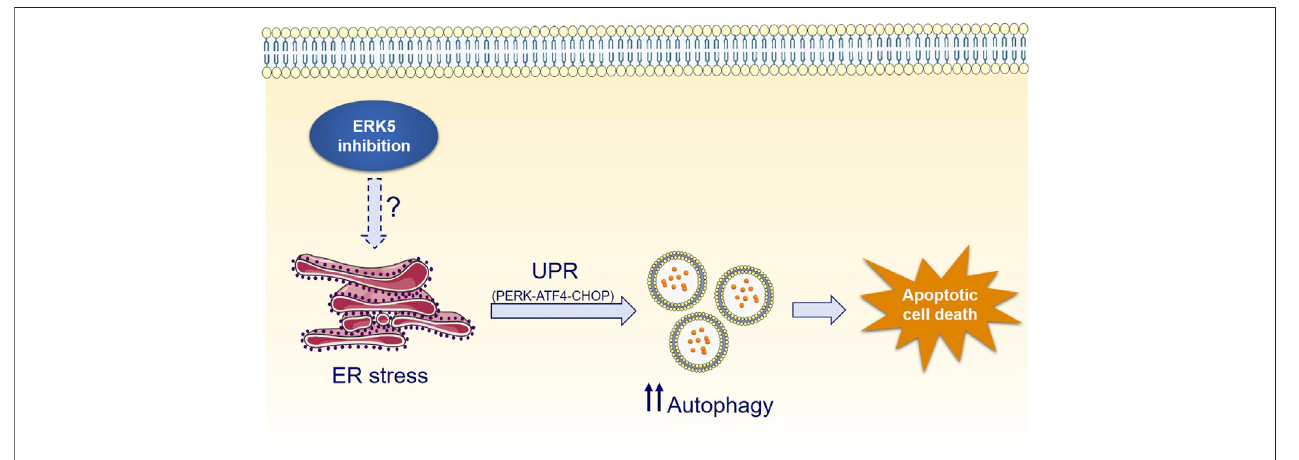
FIGURE 7 | Mechanism of ERK5i-induced cytotoxic